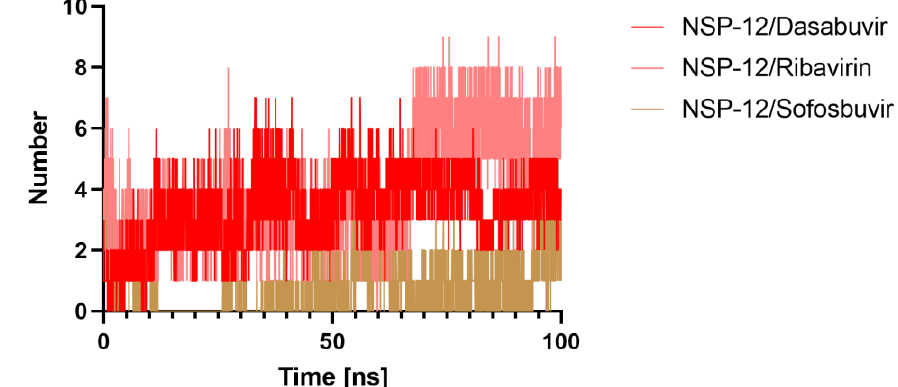
Figure 8. Intermolecular interactions. Hydrogen bonds numbers made between Dasabuvir, Ribavirin, and Sofosbuvir, with the NSP-12 protein active site residues during MD simulation.